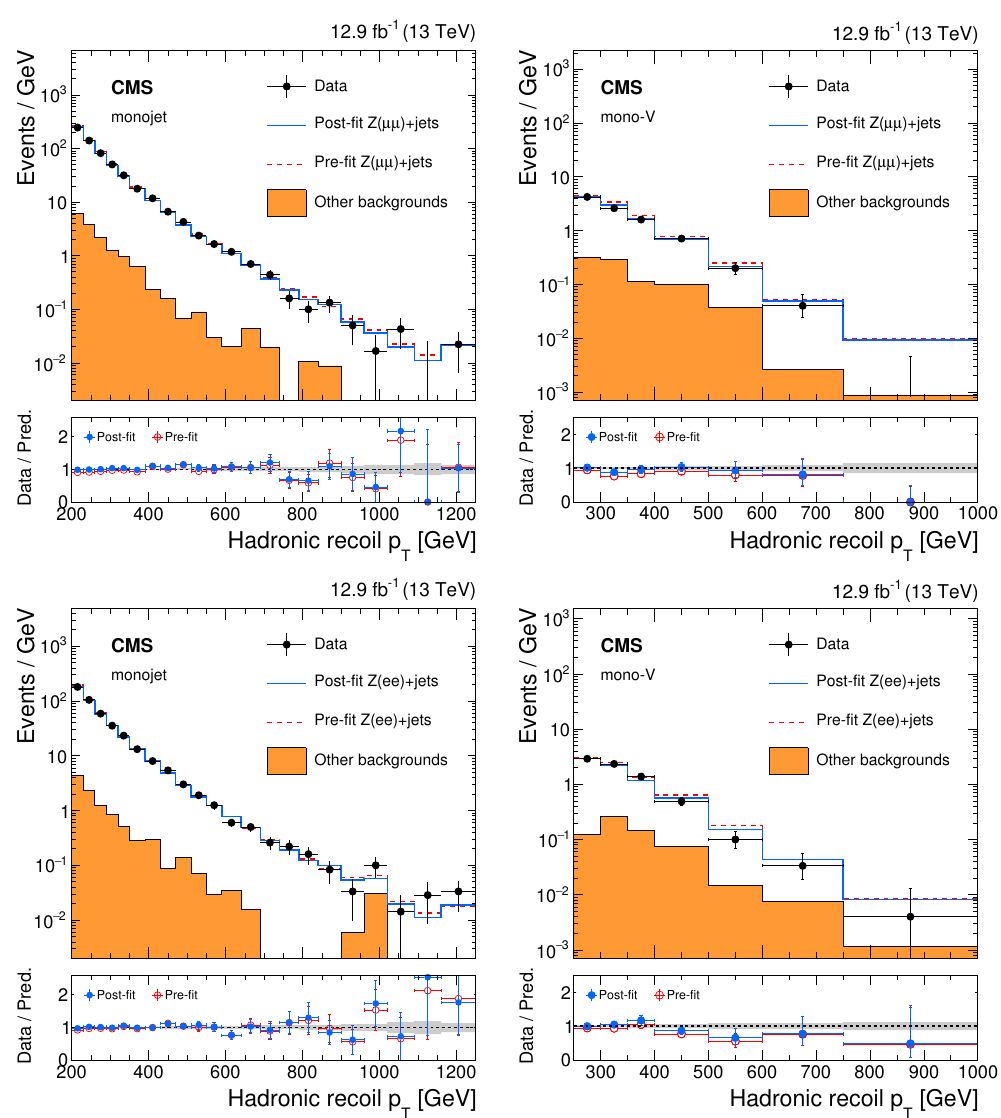
Figure 4 . Comparison between data and Monte Carlo simulation in the dilepton control samples before and after performing the simultaneous (cid:12)t across all the control samples and the signal region, assuming the absence of any signal. Plots on the upper left and right correspond to the monojet and mono-V categories, respectively, in the dimuon control sample. Plots on the bottom left and right correspond to the monojet and mono-V categories, respectively, in the dielectron control sample. The hadronic recoil p T in dilepton events is used as a proxy for E miss in the signal region. The T (cid:12)lled histogram indicates all processes other than Z( ‘ + ‘ (cid:0) )+jets. Ratios of data and the pre-(cid:12)t background prediction (red points) and post-(cid:12)t background prediction (blue points) are shown for both the monojet and mono-V signal categories. The gray band indicates the overall post-(cid:12)t uncertainty. The last bin includes all events with hadronic recoil p T larger than 1160 (750) GeV in the monojet (mono-V)